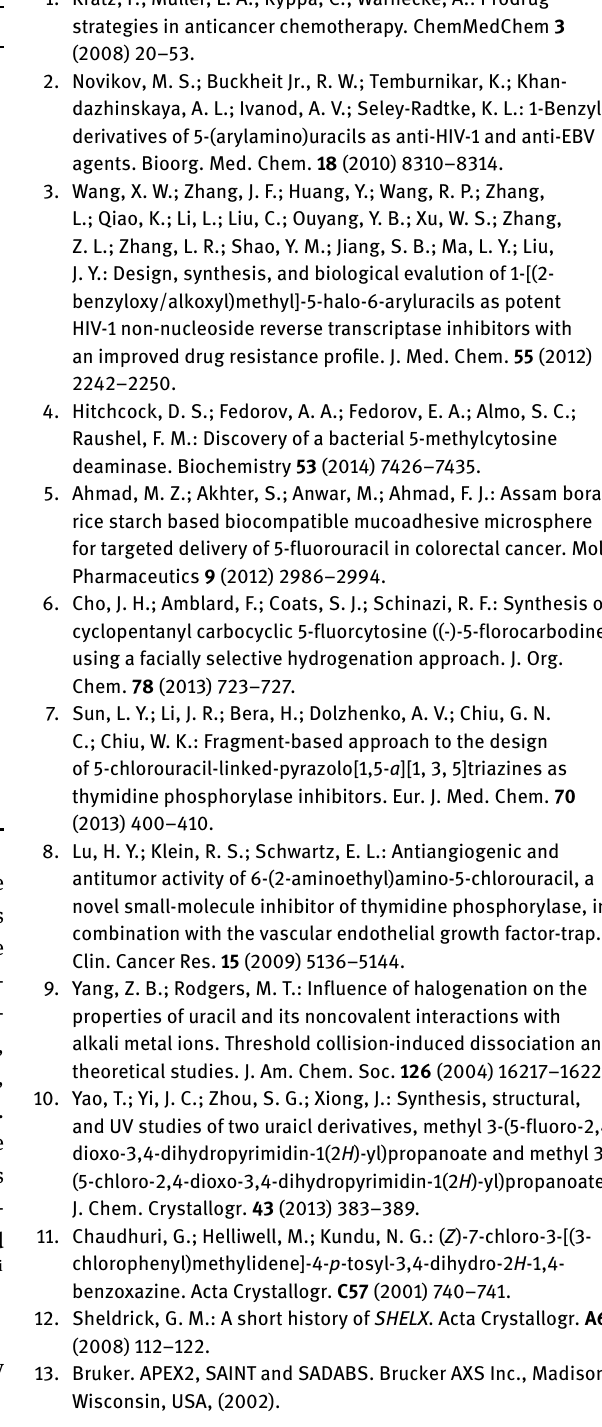
Table 2: Fractional atomic coordinates and isotropic or equivalent isotropic displacement parameters (Å 2